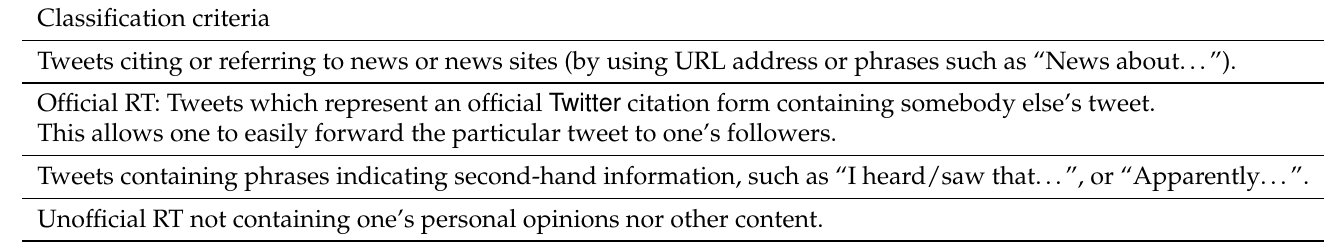
Table 3. Definition of secondary information with examples from election